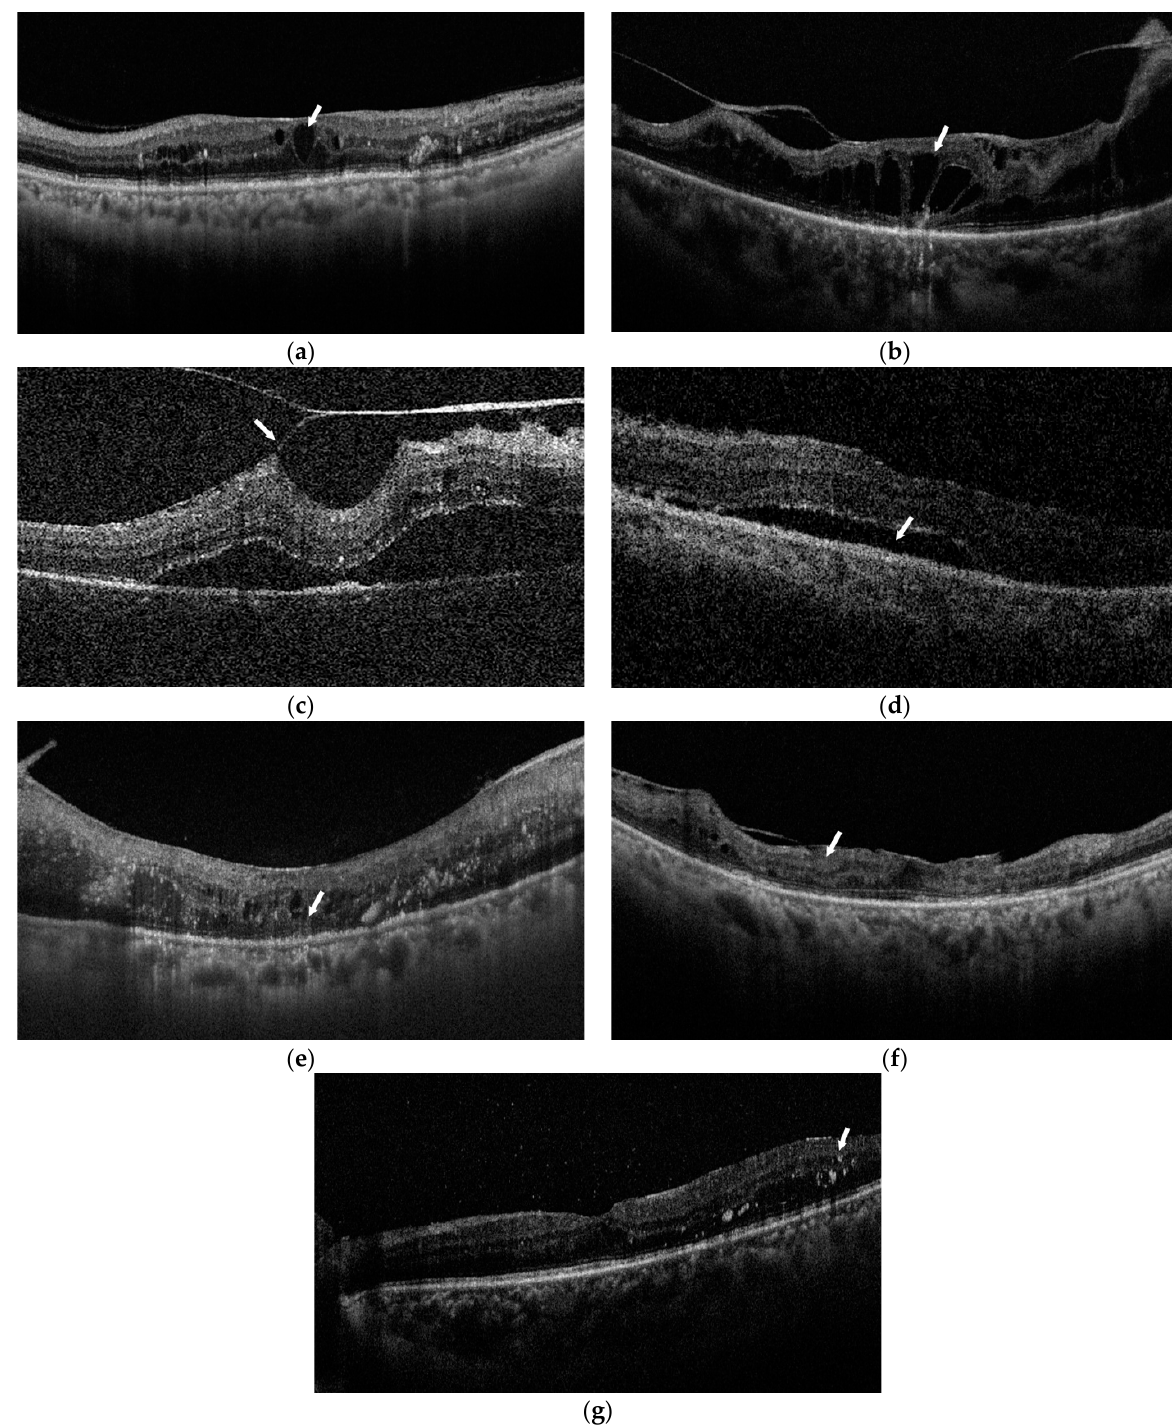
Figure 2. Categories of intraretinal changes (white arrows) on optical coherence tomography (OCT): ( a ) macular cysts; ( b ) retinoschisis; ( c ) tractional retinal detachment (TRD); ( d ) serous retinal detach- ment (SRD); ( e ) ellipsoid zone (EZ) disruption; ( f ) disorganization of retinal inner layers (DRIL); ( g ) hard exudates.